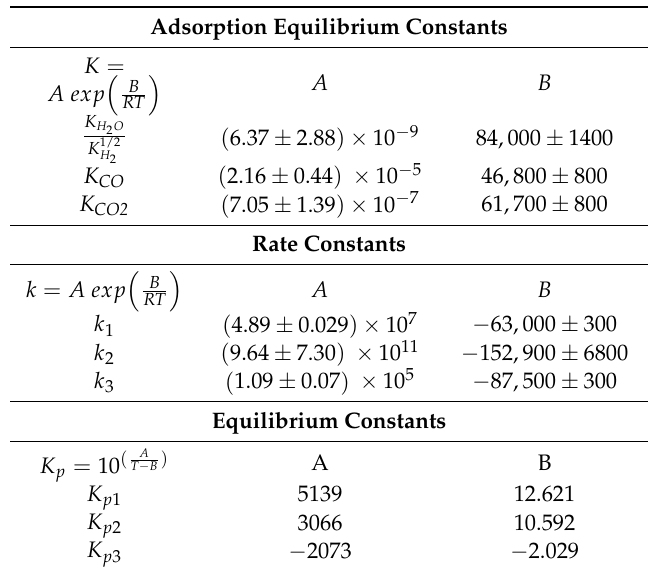
Table 1. Methanol synthesis reactions constants